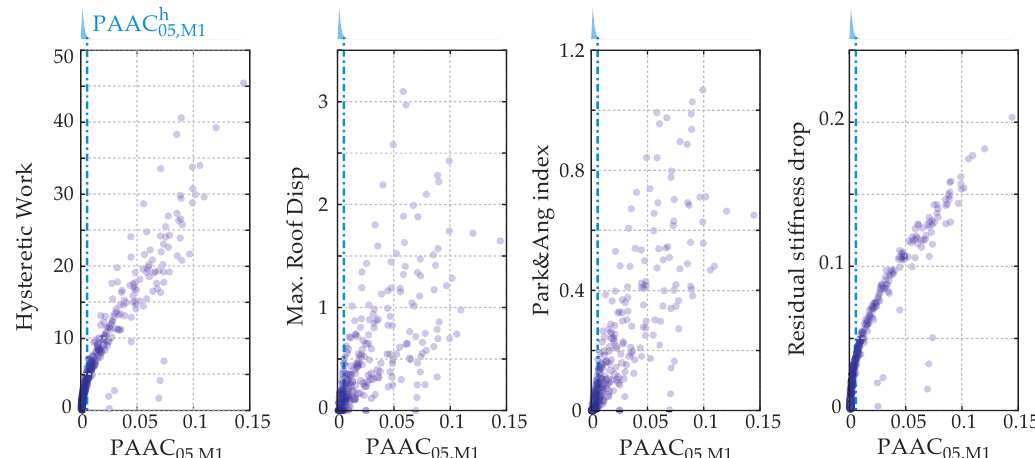
Figure 7. Evaluation of the correlation of the phase-angle-based feature, PAAC 05, M 1 , derived from post-earthquake AVs, with respect to four EDPs: hysteretic work ( left ), maximum transient roof displacement ( center left ), DI PA ( center right ), and residual stiffness drop ( right ). While a good correlation is observed with respect to hysteretic work and residual stiffness drop, the scatter under- mines the quantification of damage that depends on maximum transient displacement. The small variance in the healthy reference distribution enables the detection of damage from early